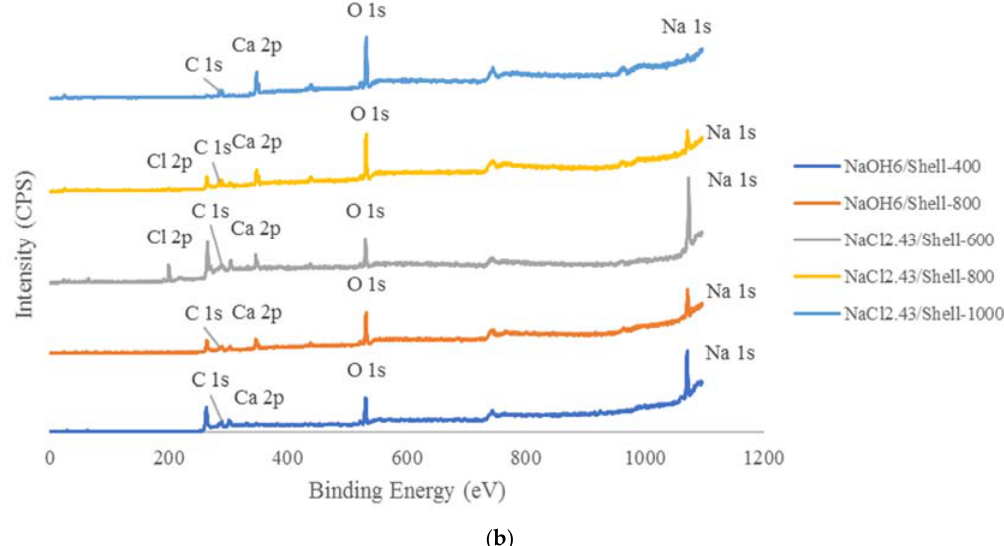
Figure 4. The XRD ( a ) and XPS ( b ) spectra of the sodium ‐ supported oyster shell catalysts. The XRD patterns of NaCl 2.43 /shell ‐ 600, NaCl 2.43 /shell ‐ 800 and NaCl 2.43 /shell ‐ 1000 are also shown